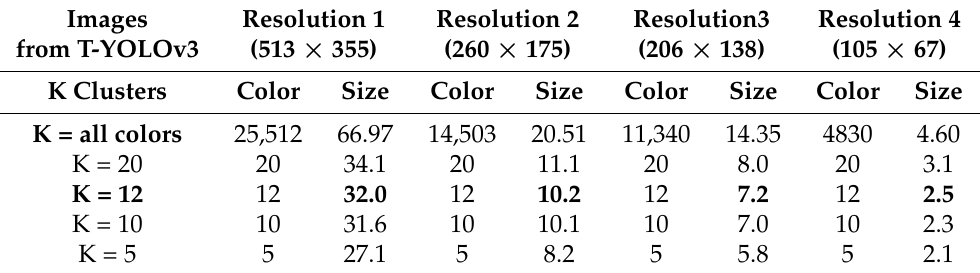
Table 3. K-means clustering on images of various resolutions, colors and sizes and the resulting images with K number of colors (clusters) and their output sizes in kB.